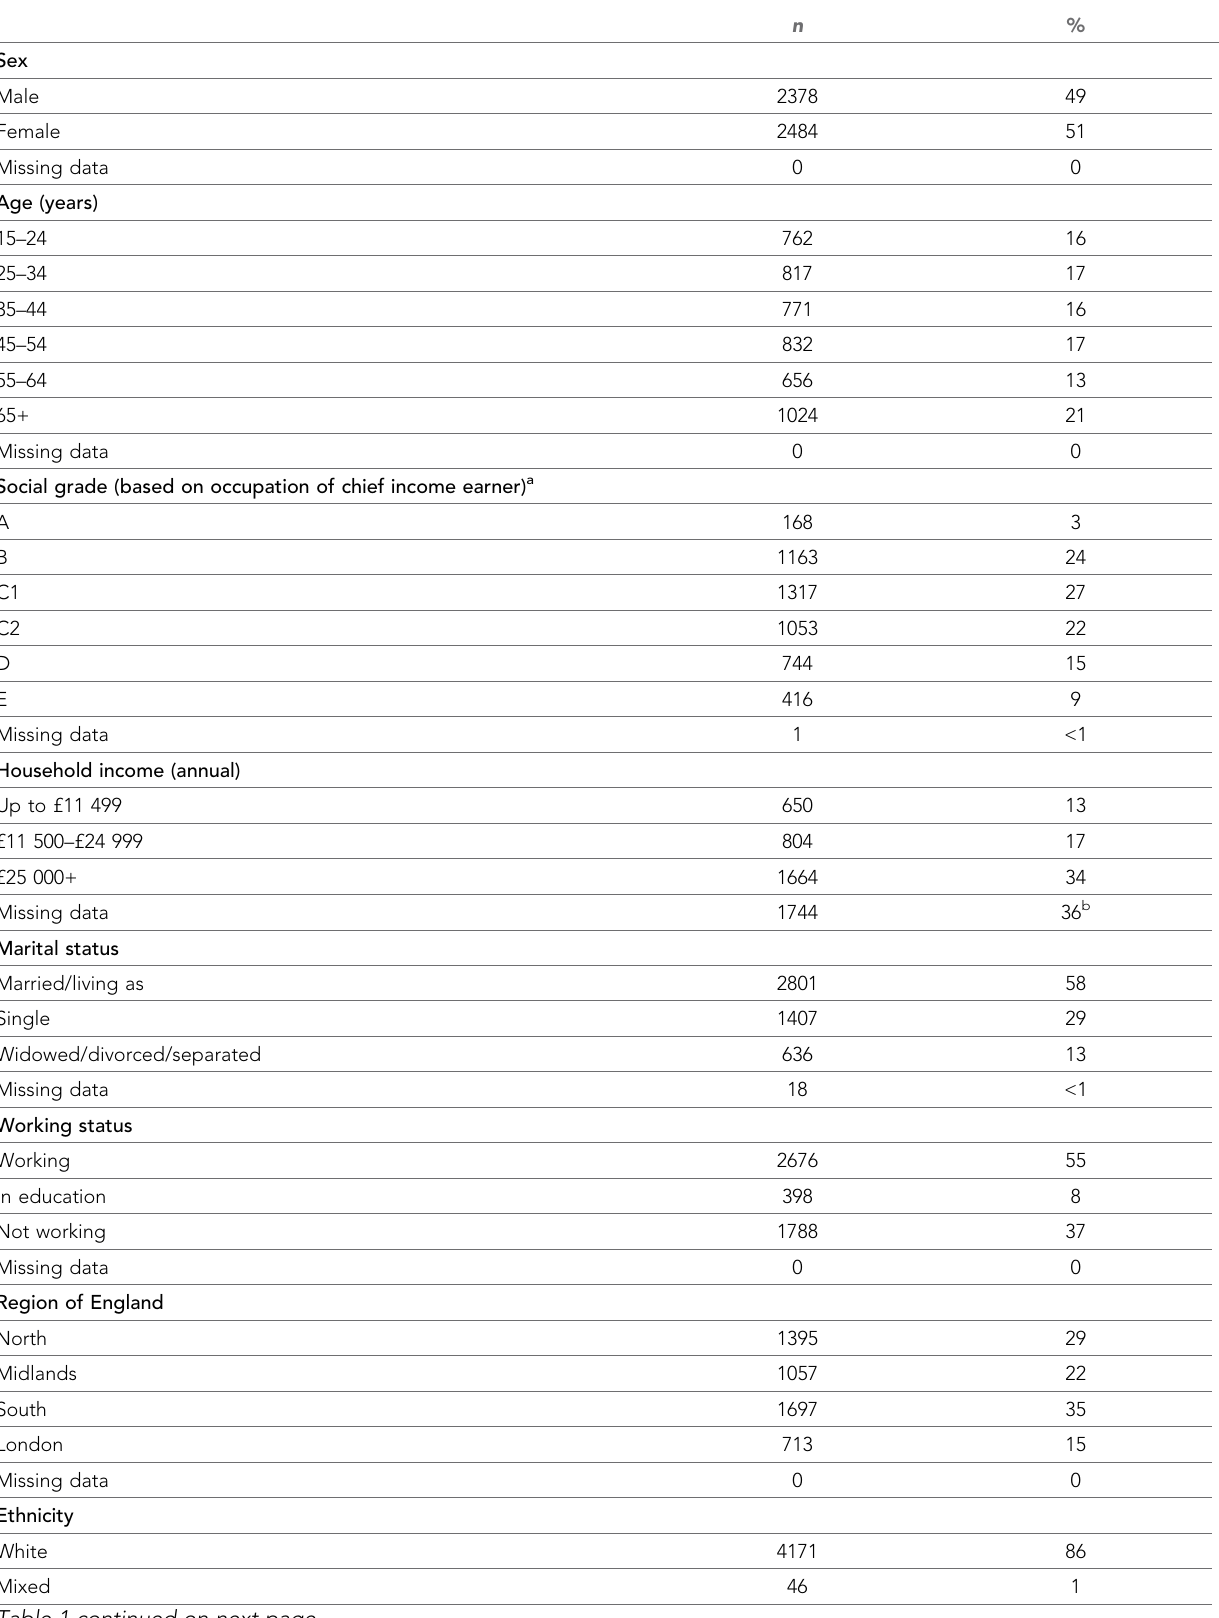
Table 1 Participant characteristics ( n =